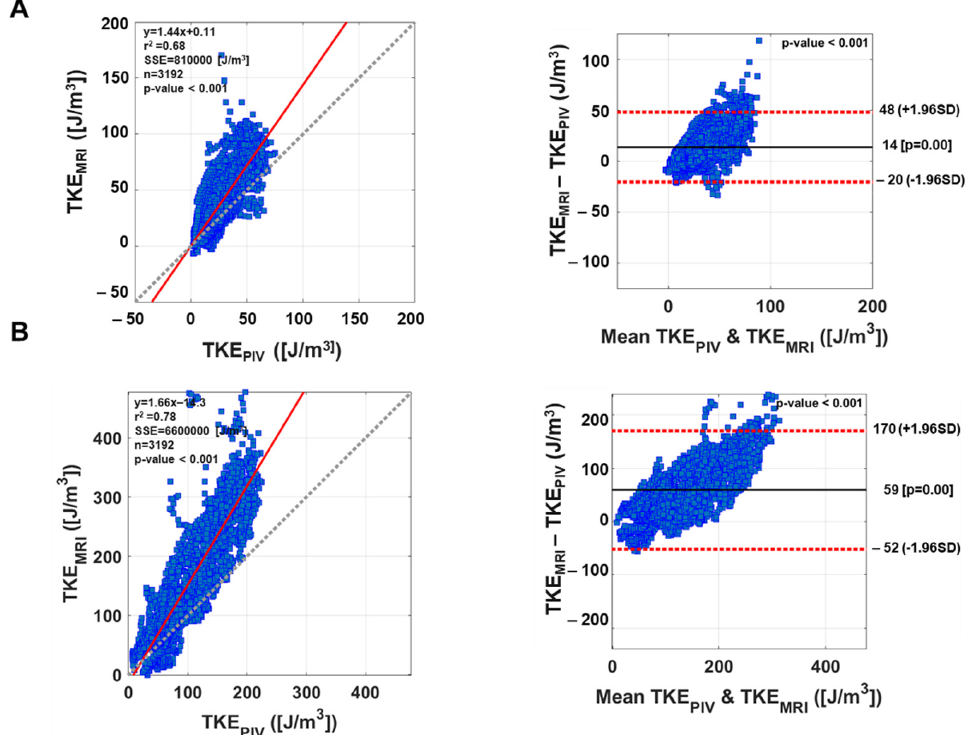
Figure 5. Bland–Altman plot of the TKE measurements. ( A ) TKE comparison at the flow rate of 10 L/min. ( B ) TKE comparison at the flow rate of 20 L/min. Solid red line indicates the slope of the linear regression. Gray dashed line indicates the slope of unity. Black solid line and red dashed line are mean ± 1.96SD.